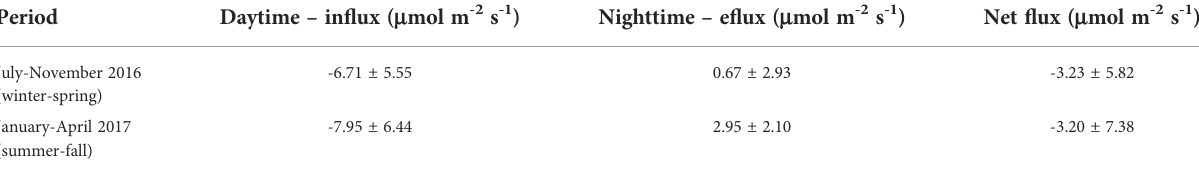
TABLE 1 Mean (± standard deviation) values of salt marsh-atmosphere CO 2 fl ux during daytime, nighttime and daily cycle net balance, for both studied periods. Period